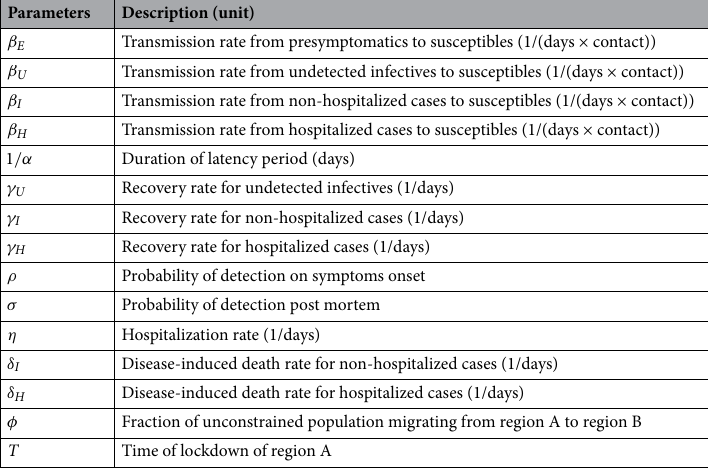
Table 1. Interpretation of model